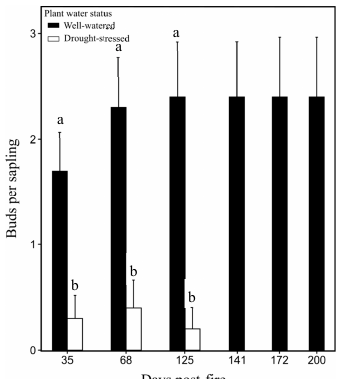
Figure 4. Average bud count per sapling (±SE) in well-watered and drought-stressed Pinus ponderosa saplings burned at 0.7 MJ m -2 from day 35 to 200 days post-fire. Mean values sharing the same letter are not significantly different ( P < 0.05).